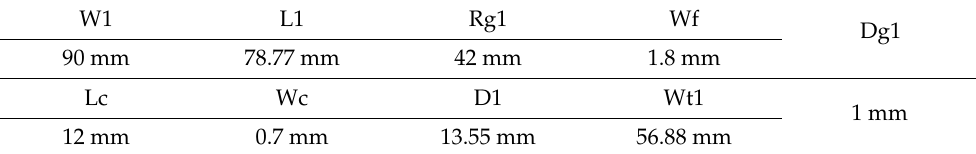
Table 4. Physical parameters of proposed slot antenna 4.